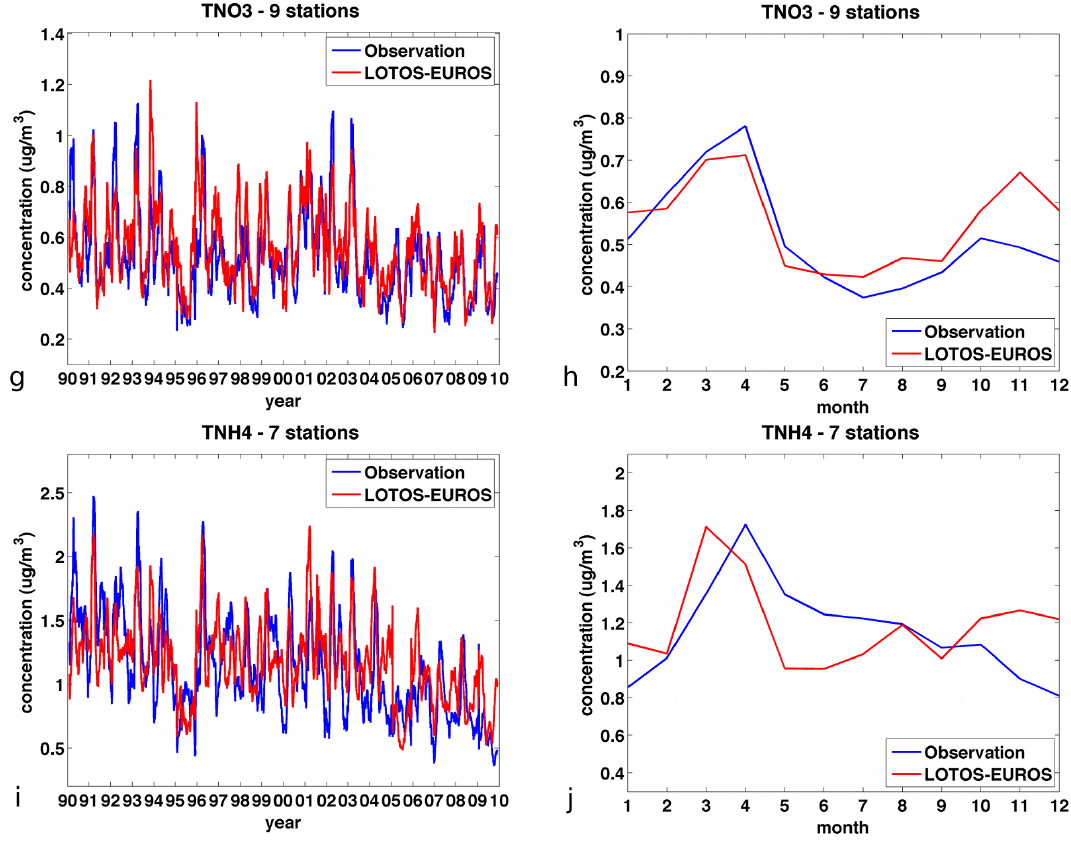
Figure 3. Mean 60day moving average (left panel) and seasonal cycle (right panel) of (a–b) SO 2 , (c–d) SO 2 − (i–j) TNH 4 for the time period 1990–2009. The number of considered stations is given in the figure